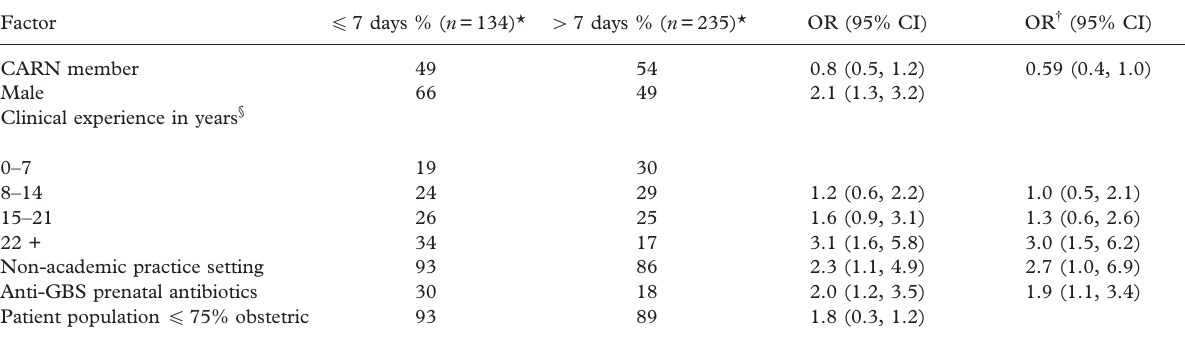
Table II. Factors associated with obstetrician-gynecologists who continue antibiotics for more than 7 days for women with pPROM and negative GBS cultures